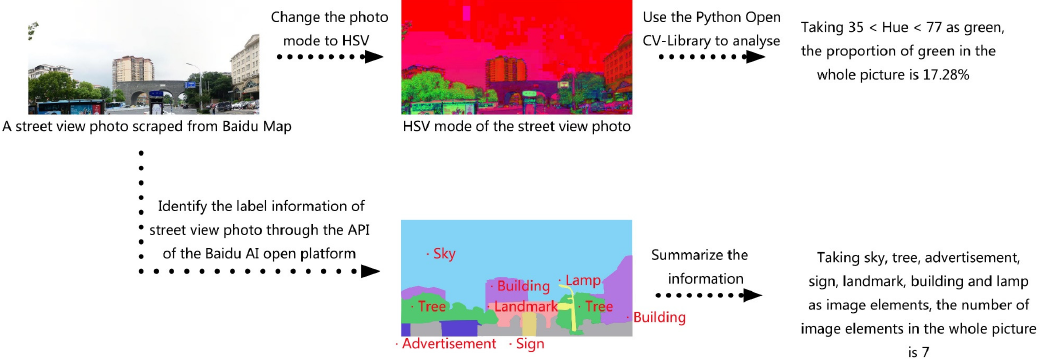
Figure 3. Indices diagram of green visual ratio and image elements of street view photo.